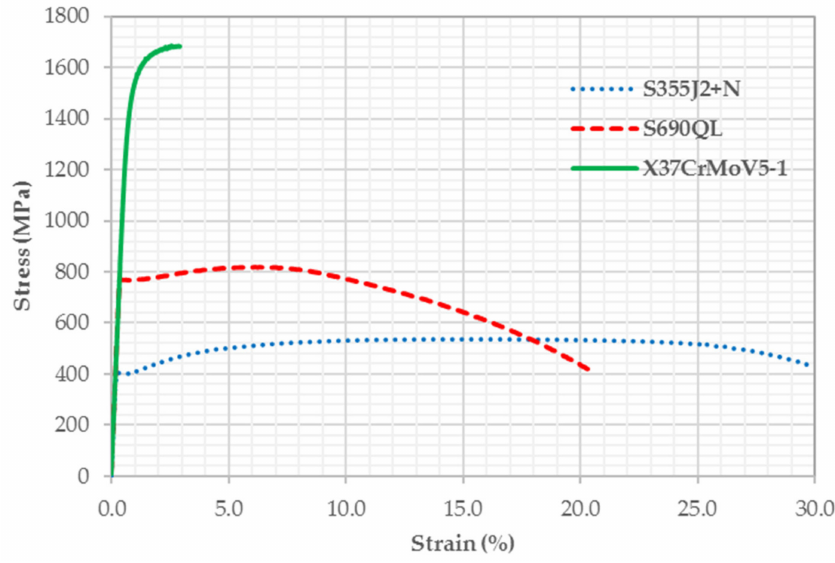
Figure 4. Stress–strain curves for S355J2+N, S690QL, and X37CrMoV5-1 steel